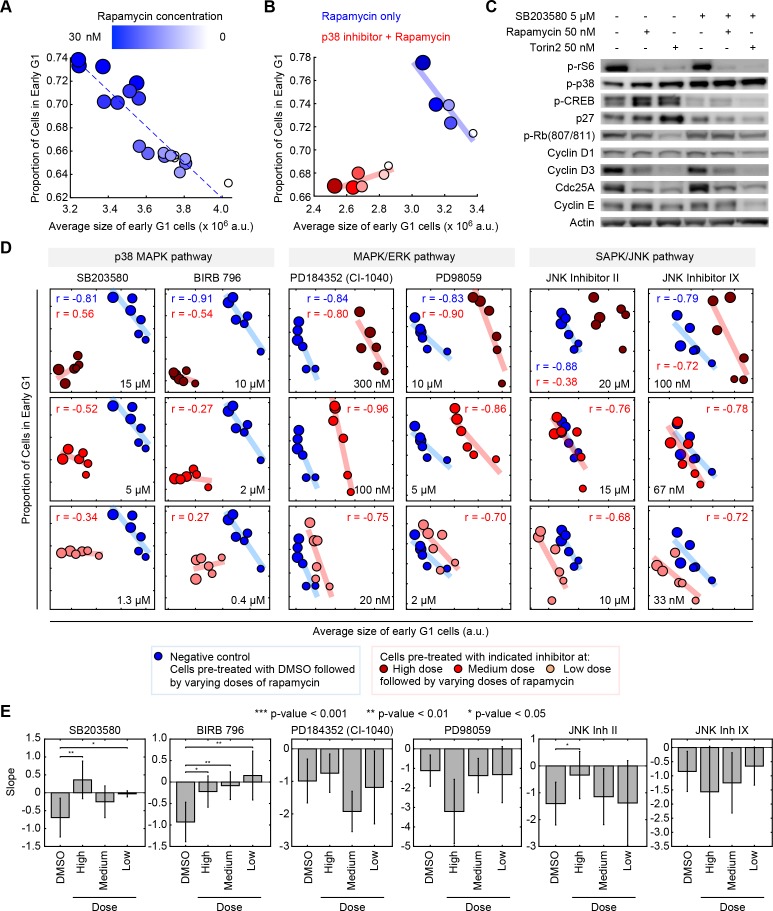
Pharmacological inhibition of the p38 MAPK pathway disrupts the coordination of cell size and G1 length.(A) Quantifying the coordination of cell size and G1 length. Samples of unsynchronized cells were treated with increasing concentrations of rapamycin (a rapamycin concentration series: 0, 0.03, 0.3, 3 and 30 nM) for a period of 24 hr, and then stained and imaged to quantify cell size and cell cycle stage on a single-cell basis. Each data point (circle) corresponds to a different concentration of rapamycin and shows the average size of early G1 cells and the proportion of cells in G1 resulting from that treatment. Populations treated with higher concentrations of rapamycin had smaller cells and higher fractions of cells in G1, resulting in a robust negative correlation. Rapamycin concentrations are redundantly represented by both the size of the circles and their color, as shown in the colorbar. The small white circles represent control populations that were treated with DMSO, rather than rapamycin. Calculation of the average size and the proportion of G1 cells, in each of the represented samples, was performed by classifying single cells into cell cycle stage as depicted in Figure 1B. Each data point was measured from an unsynchronized population with a minimum of 7000 cells. Additional details on the experiment and analysis is provided in the Materials and methods section. (B) The experiment described in panel A is repeated with (red) or without (blue) a chemical inhibitor of p38 (SB203580, 5 μM). The negative correlation between the size of early G1 cells and the proportion of cells in G1 is apparent in populations not treated with SB203580 (blue) but not in the populations that are treated with SB203580. The blue and red trend lines represent linear regressions. (C) Western-blots of whole cell lysates from populations that were treated with different combinations of SB203580, rapamycin and Torin-2. The experimental procedure used here are the same as those used to generate the data shown in panel A and B. The increased levels of phopho-p38 in the population that is treated with SB203580 (a p38 inhibitor) should not be interpreted as a lack of efficacy of SB203580. Rather, these higher levels of phopho-p38 are explained by a negative feedback in the p38 pathway (Arthur and Ley, 2013), and the fact that while p38 inhibitors prevent p-p38 from phosphorylating its downstream substrates, these inhibitors do not block phosphorylation of p38 itself by upstream regulators (Kumar et al., 1999). (D) Inhibition of the p38 MAPK pathway, but not the MAPK/ERK or SAPK/JNK pathways, disrupts the correlation between the average size of early G1 cells and the proportion of cells in G1. Results were obtained with the same assay used to create panel A and B. Larger circle size indicates higher rapamycin concentration. The rapamycin concentration series includes: 0, 0.03, 0.1, 0.3, 3 and 30 nM. The results shown here are representative of three independent experiments. (E) Fitted slopes corresponding to the trends shown in Figure 2D. Error bars represent 90% confidence intervals. For each compound treatment, its fitted slope is compared with the slope of the control (DMSO) from the same experiment. Significance was calculated with one-tailed Student’s t-test (H0: slopedrug <= slopecontrol). The meta data and source code used for this analysis and visualization of results is presented in Figure 2—source data 1.10.7554/eLife.26947.017Figure 2—source data 1.Measurements of cell size and cell cycle stages from the chemical inhibitor experiments as shown in Figure 2D, Figure 2—figure supplements 2 and 3.